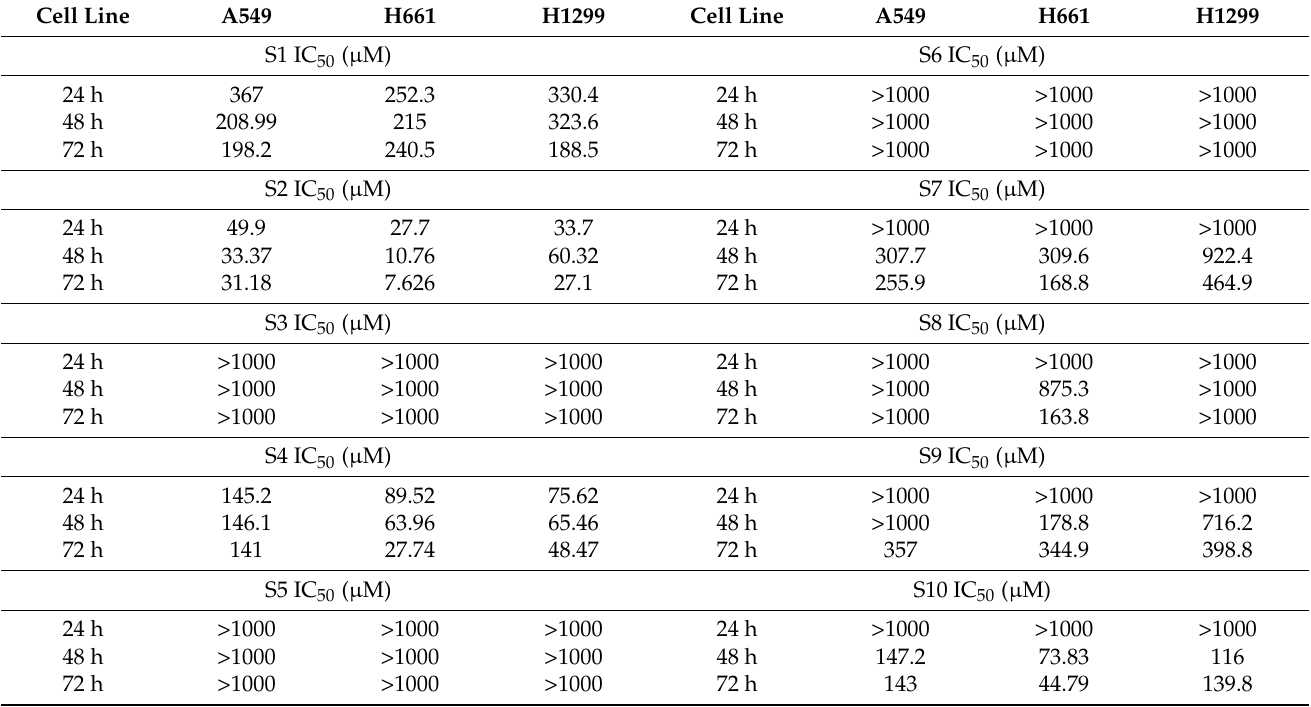
Table 2. The 50% inhibitory concentration (IC 50 ) values for MAO-A inhibitors in A549, H1299, and H661 lung cancer cells at 24, 48, 72 h. Experiments were carried out in duplicate at 4 independent times ( n = 8). SD did not exceed 5%. SD: standard deviation, h: hour; µ M: